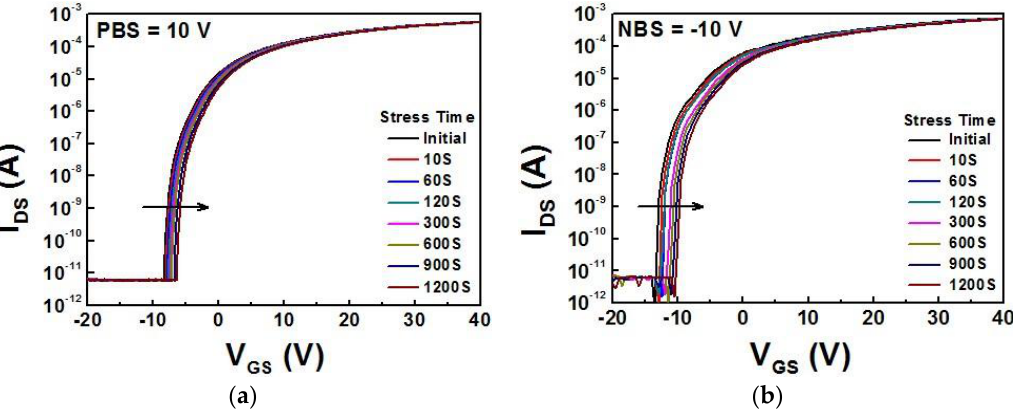
Figure 5. Transfer curves of amorphous IZTO (a-IZTO) thin film transistors annealed at 350 °C as a function of stress time under ( a ) positive bias stress (PBS) and ( b ) negative bias stress (NBS).